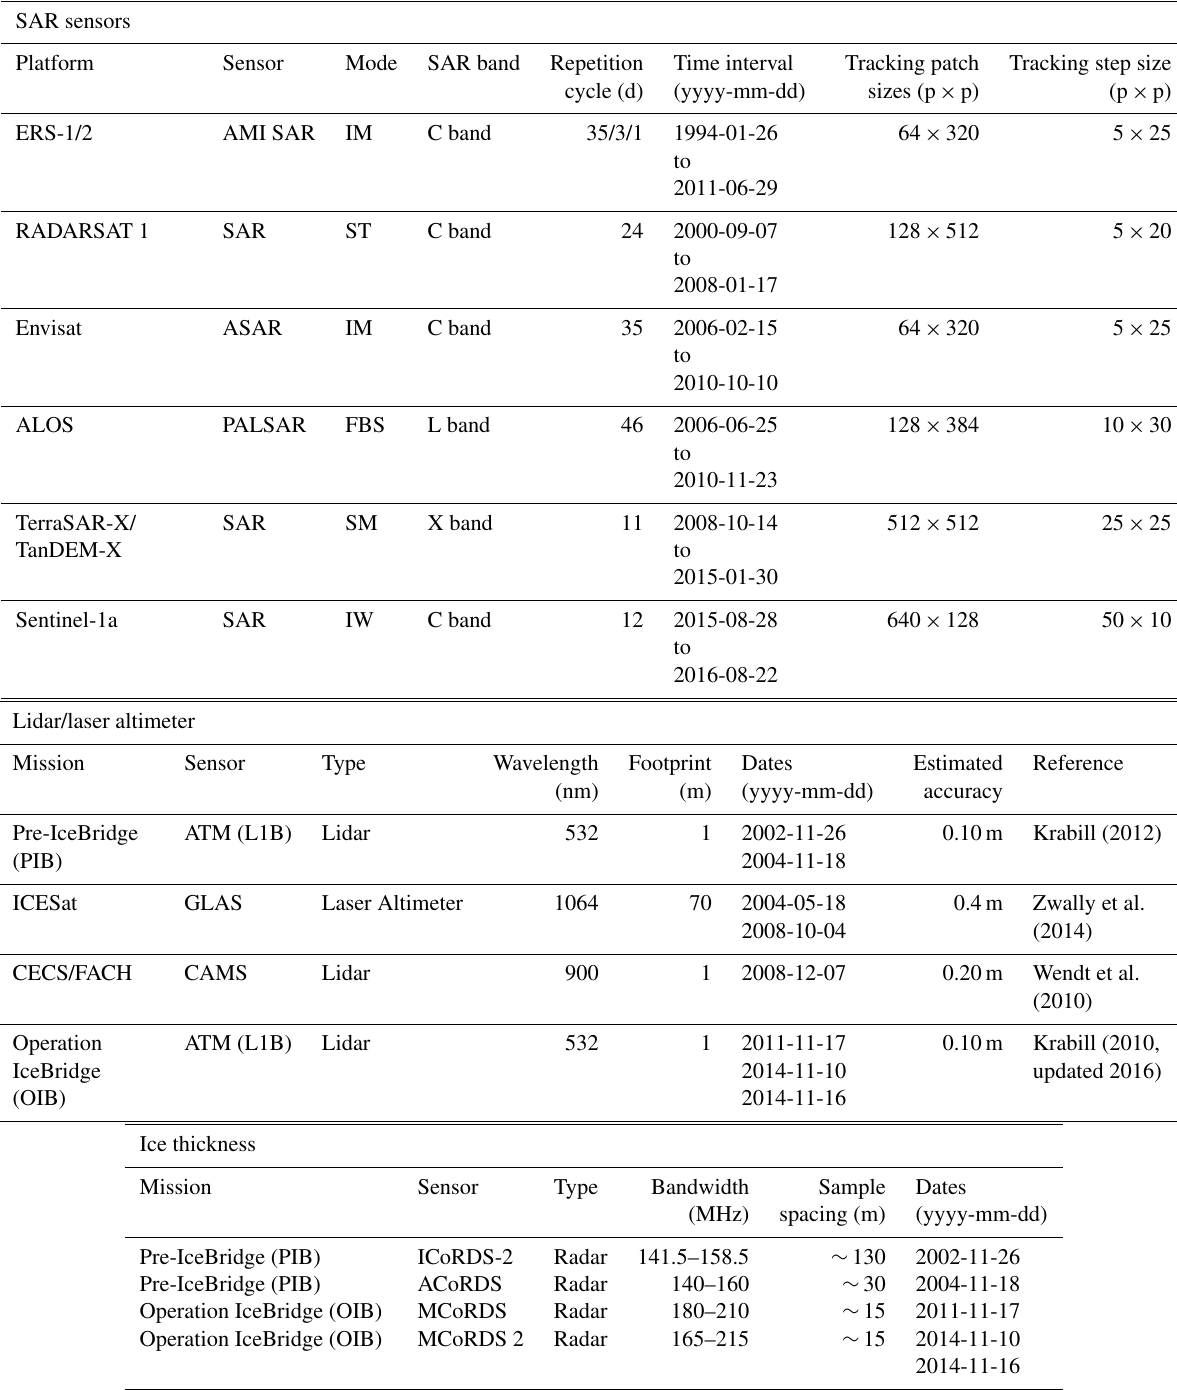
Table 1. Sensors and data used in this study and their main specifications. Intensity tracking parameters are provided in pixels (p) in slant range